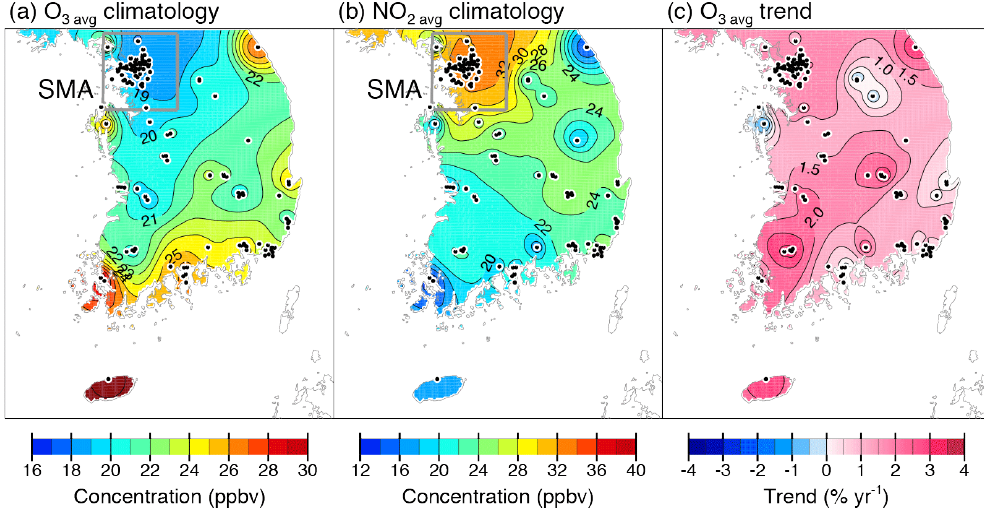
Figure 3. Spatial distributions of 12yr averaged concentrations of (a) daily average O 3 (O 3avg ) , (b) daily average nitrogen dioxide (NO 2avg ) , and (c) temporal linear trends of O 3avg for the period 1999–2010 using data from 124 air quality monitoring sites (black dots) of NIER.